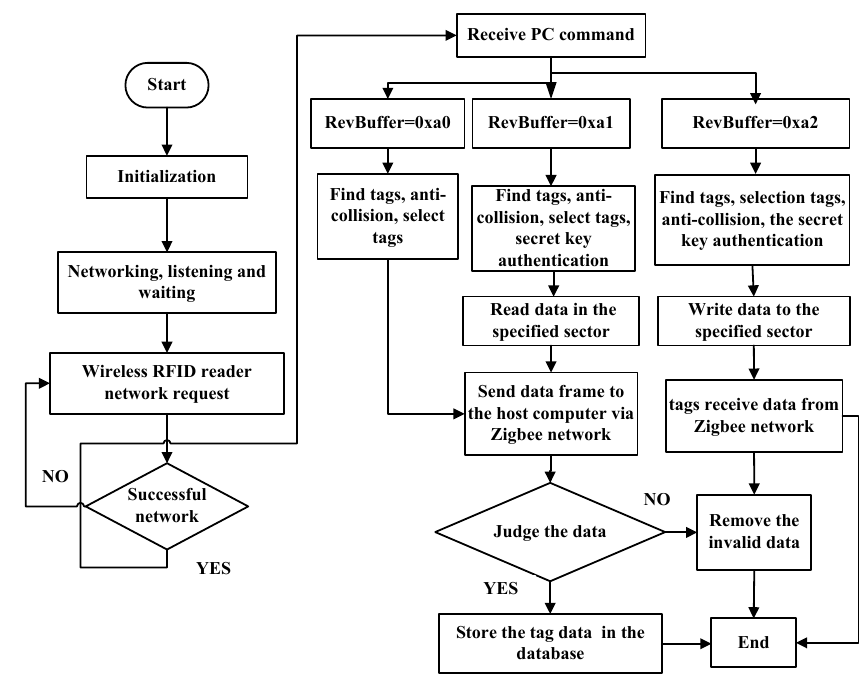
Figure 6. System main program flow chart.